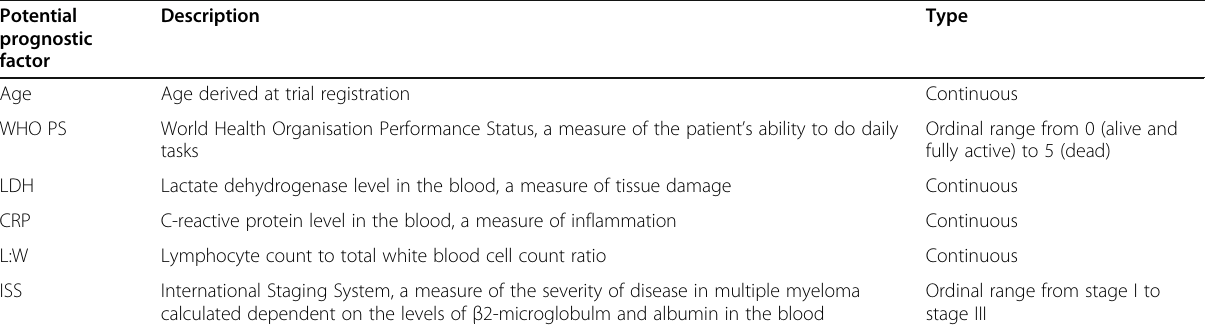
Table 1 Potential prognostic factors considered for inclusion within the prognostic model Potential prognostic